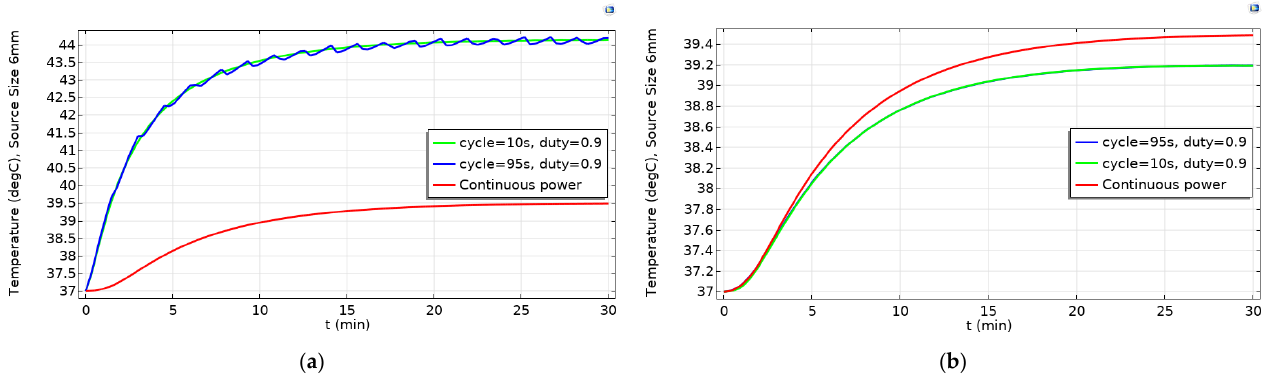
Figure 5. The temperature at ( a ) tumor domain and ( b ) tumor neighboring domain with source diameter of 6 mm during the 30-min simulation.